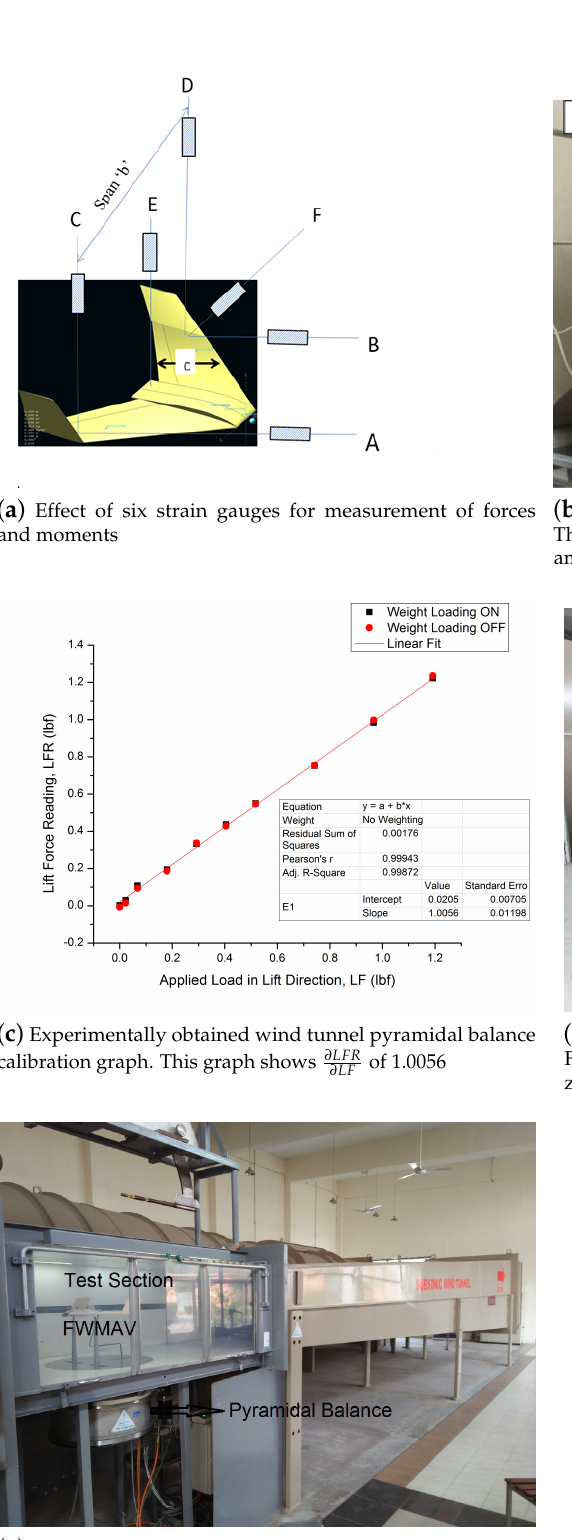
Figure 5. Wind Tunnel